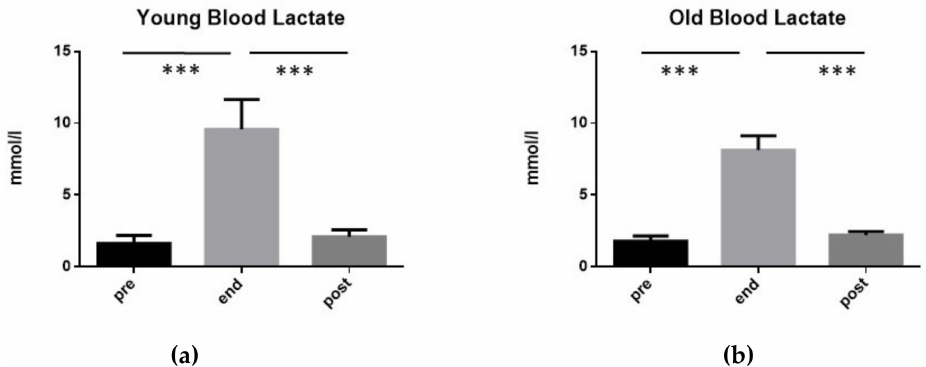
Figure 1. Blood lactate values of the 15 subjects of group YOUNG ( a ) and of the 15 subjects of group OLD ( b ) performing an exhaustive exercise. In both cases, blood lactate mean values measured before the exercise (pre), at its conclusion (end), as well as 15 min after its end (post) are illustrated. Symbols from ANOVA with Dunn’s multiple comparison test: *** p < 0.001.